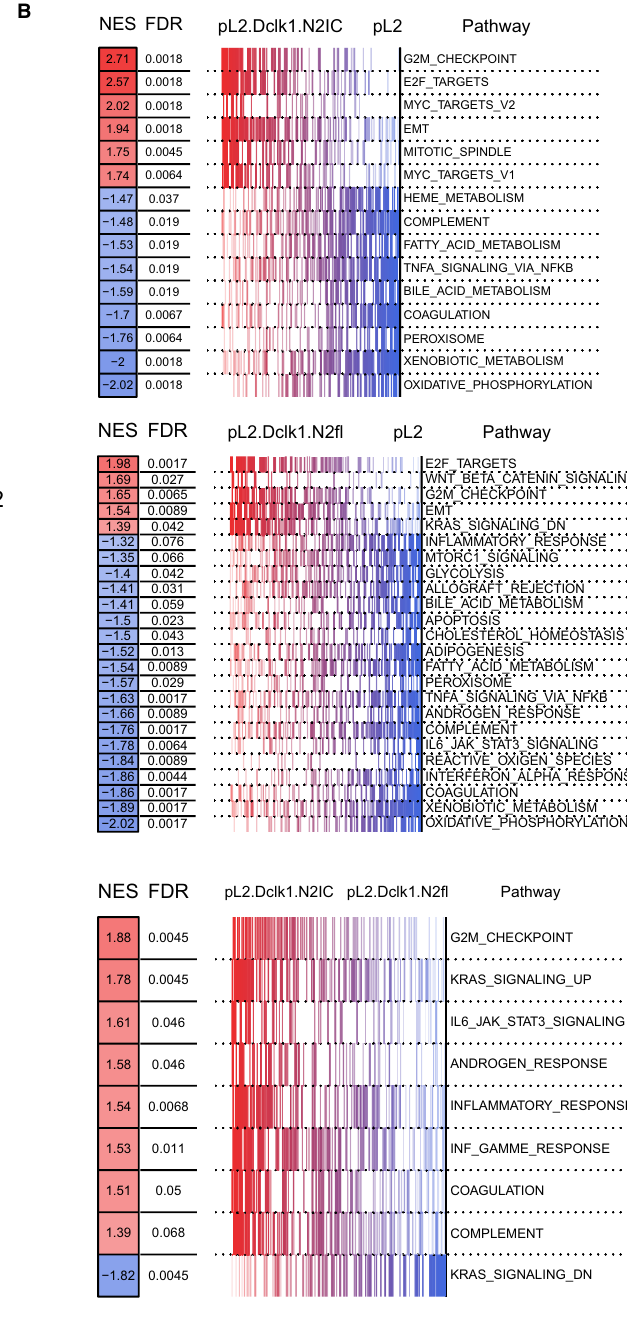
Figure 5. Notch activation in Dclk1-positive crypt epithelial cells induces upregulation of oncogenic signaling. ( A ) Analysis of HALLMARK gene sets (OneVsRest) of the indicated genotypes, scale bar indicates log2- fold changes of genes (Z-Scores; positive lgFC indicates higher gene expression in the respective group). ( B ) Grouped analyses of the indicated genotypes for changes in hallmark pathway gene sets, NES = normalized enrichment score, FDR = false discovery rate (red indicating increased, blue indicating